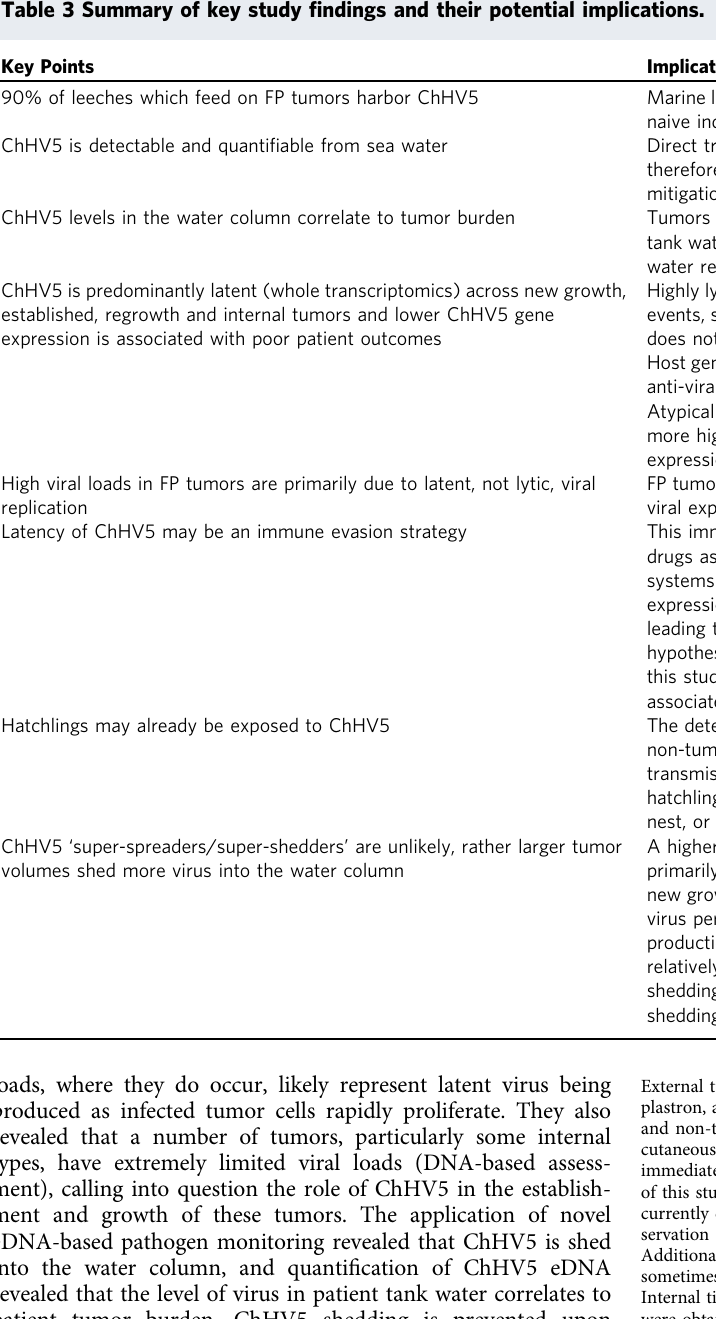
Table 3 Summary of key study fi ndings and their potential